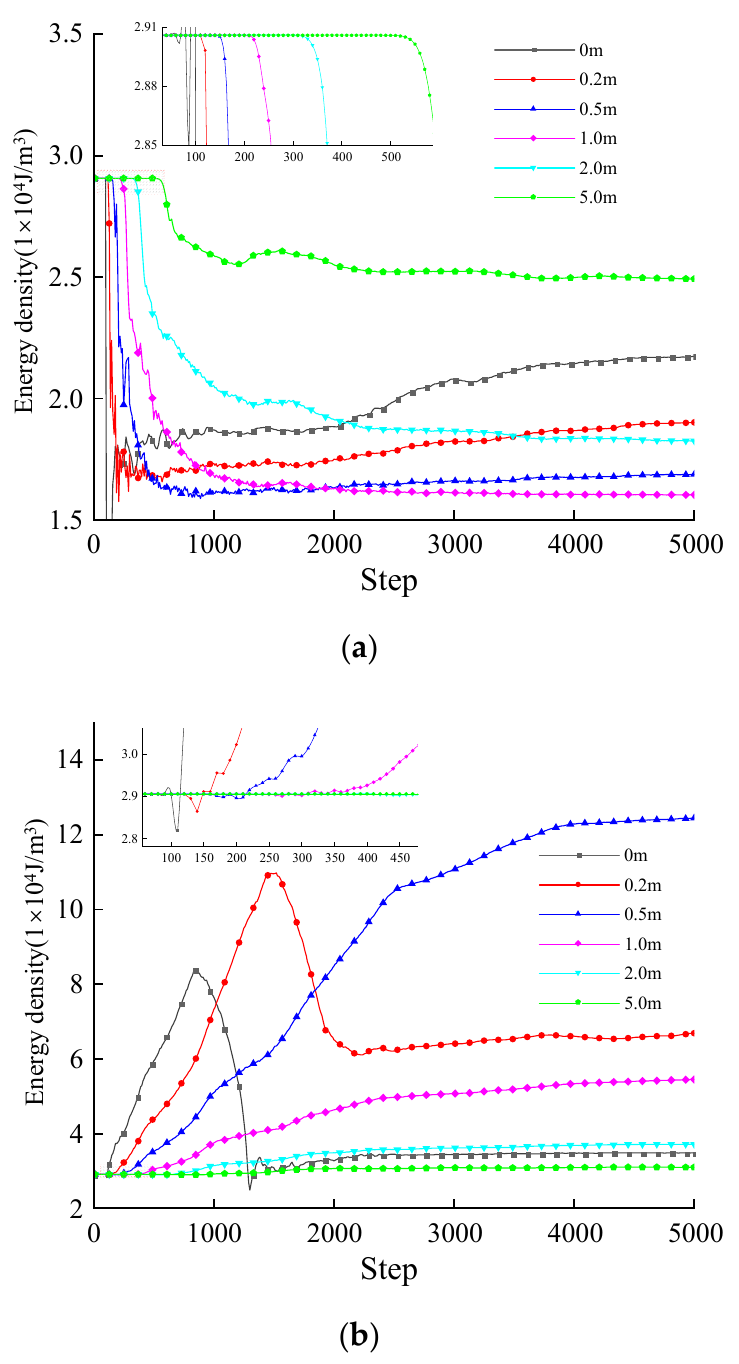
Figure 5. Energy path of elements at different depths of the tunnel wall: ( a ) measuring point in the maximum principal stress direction; ( b ) measuring point in the minimum principal stress direction. The local energy release effectiveness (shown in Figure 8) could be calculated with the maximum energy density before and after the energy release, as well as their occurrence time. Taking one-tenth of the maximum value as the lower limit of the contour plot, it can be observed that the distribution of local energy release effectiveness aligned with the actual location of the rockburst well. The maximum radius was between 2.20 and 2.257 m, which was approximately 1.26–1.29 times the radius of the excavation zone, which closely matches the actual radius of 1.3